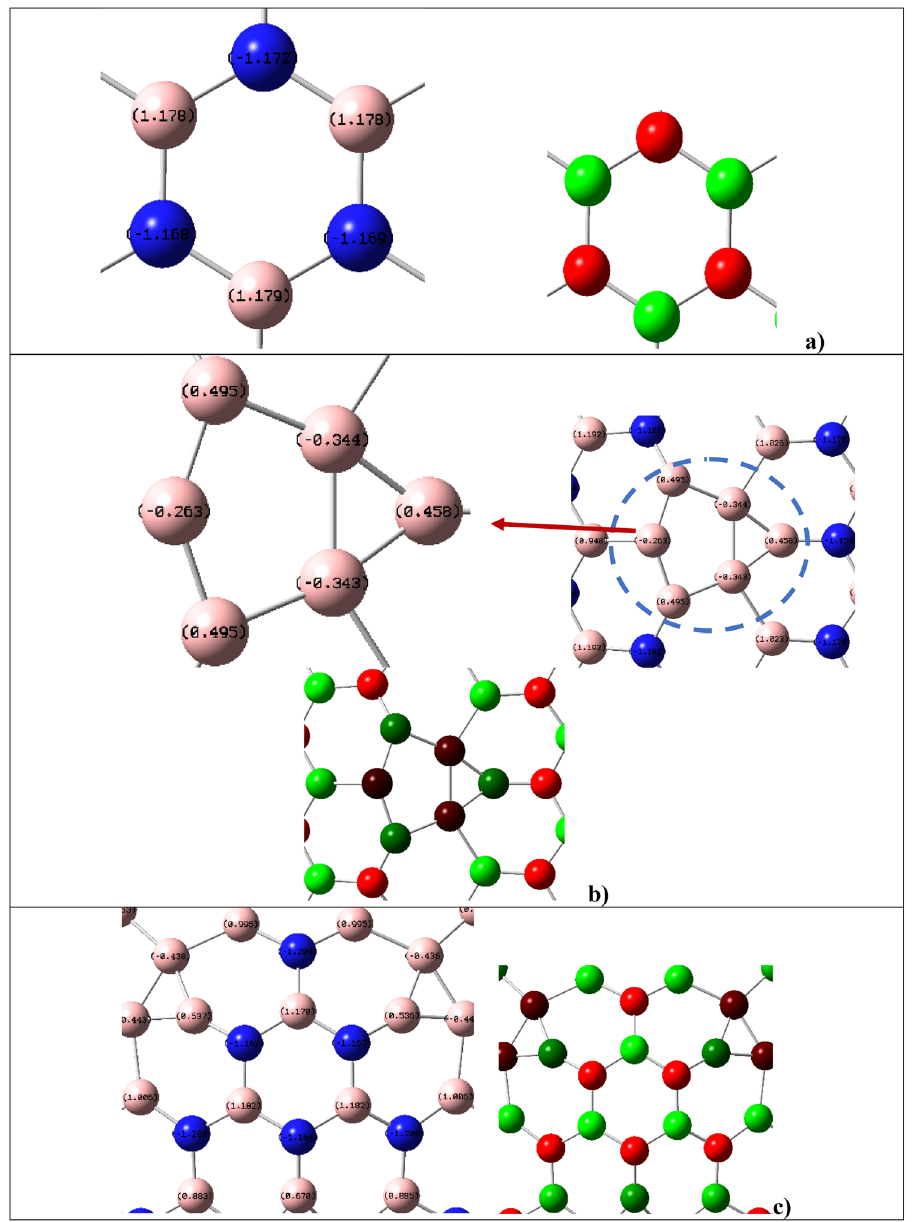
N H 30 24 18 N H 33 21 18